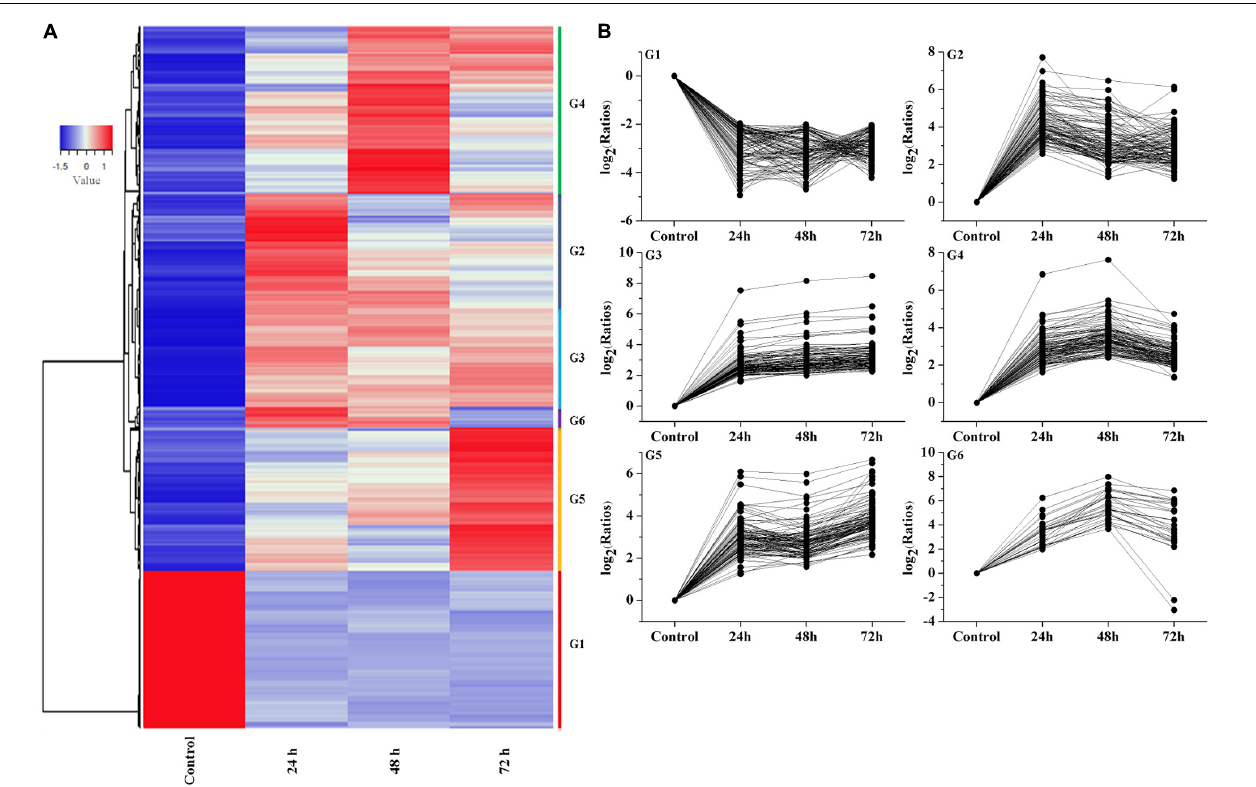
FIGURE 5 | Analysis of temporal expression pattern of genes. (A) Heat map analysis of DEGs. (B) Expressive trend pattern analysis of DEGs. The value of ratios take the base 2 logarithm were used to analysis each gene‘s expression trend in every group. For each gene, ratios = FPKM of the gene in sample/FPKM value of the gene in